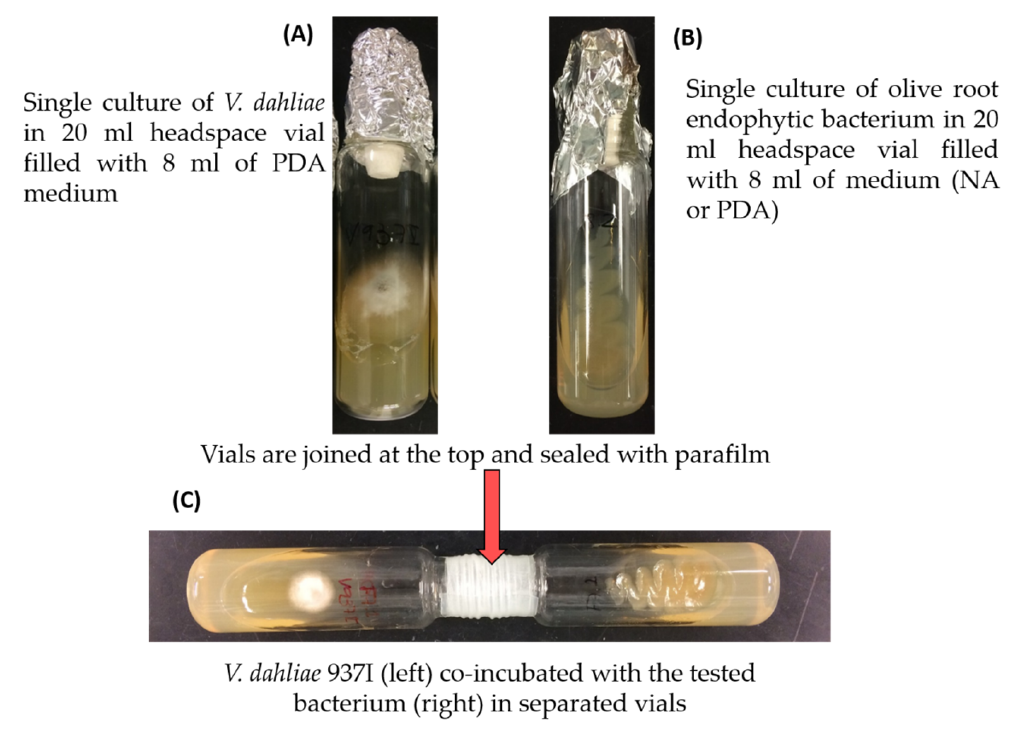
Figure 1. Culture headspaces sampling setup to characterize the volatile organic compounds of antagonistic olive root endophytes and Verticillium dahliae V937I. ( A ) Verticillium dahliae V937I, ( B ) bacteria and ( C ) bacteria in the presence of V. dahliae .